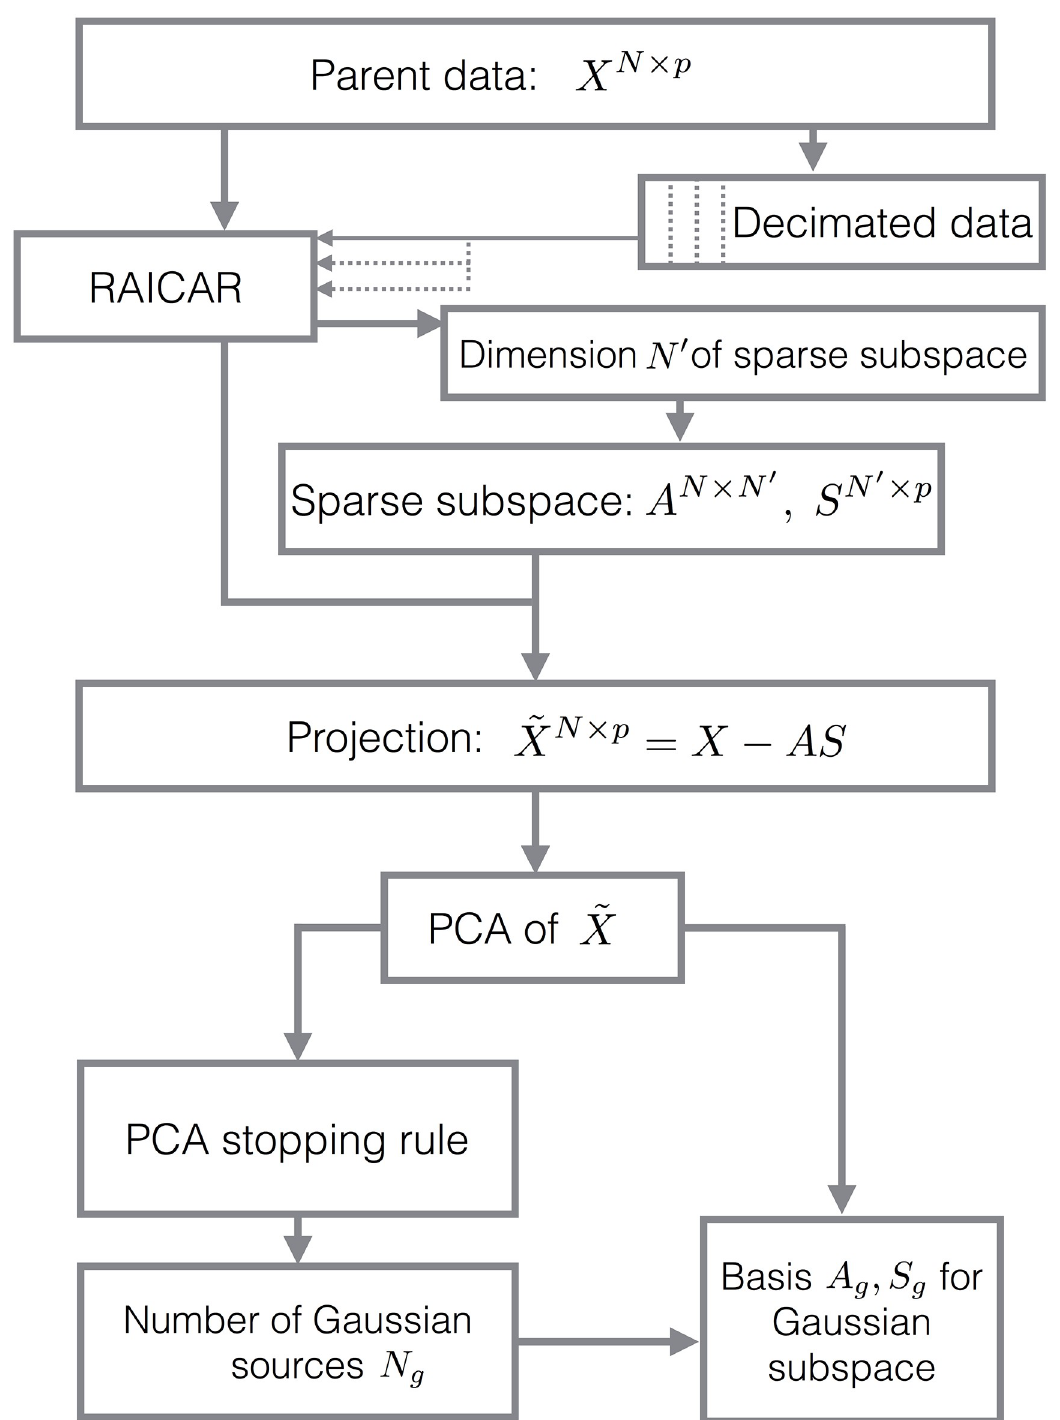
Fig 1. Schematic for MIPReSt. MIPReSt runs the RAICAR algorithmon both the originaldata matrix X and many random subsamples of smaller column dimension. Comparisonof the reproducibilitiesfrom the originaldata and the random subsamples determines the size of the sparse subspace. After projecting that subspaceout of X , singularvalue decomposition ~ X , along with an eigenvalueselectionrule, produces both the dimensionof the Gaussian subspaceand a basis for that subspace.(See Methods for details.).